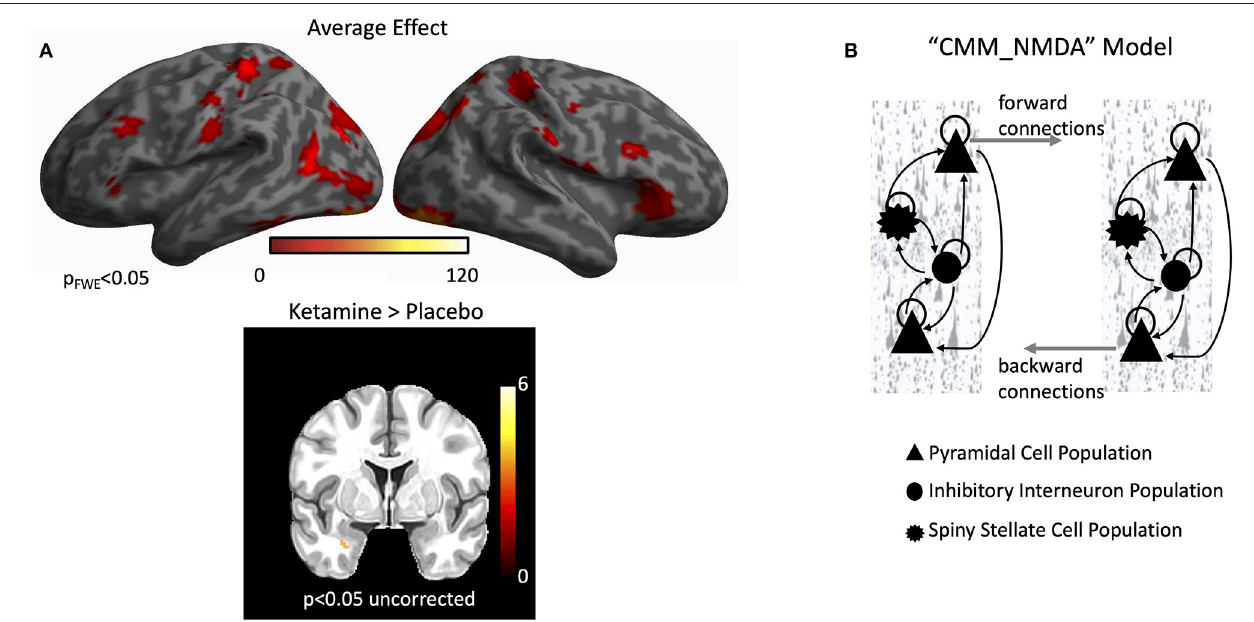
FIGURE 1 | Gamma power and dynamic causal modeling (DCM). (A) A network of regions showed robust increases in induced gamma power during the task. These included the bilateral early visual cortex, bilateral fusiform cortex, and bilateral inferior frontal gyrus. When directly testing the effect of infusion, higher induced gamma power was found in the left amygdala for the ketamine infusion. (B) The default CMM_NMDA model includes four distinct intrinsic (within region) cell layers: superficial pyramidal cells, spiny stellate cells, inhibitory interneurons, and deep pyramidal cells [adapted from Gilbert et al. (57)]. Intrinsic excitatory connections were mediated by α -amino-3-hydroxy-5-methyl-4-isoxazolepropionic acid (AMPA) and N-methyl-D-aspartate (NMDA) receptors while intrinsic inhibitory connections were mediated by gamma aminobutyric acid (GABA) receptors. Each cell population included a self-gain parameter that reflected precision for each cell type. Each receptor also included distinct time constants and dynamics in the model. Between regions, superficial pyramidal cells carry forward extrinsic signals to excitatory spiny stellate cells. Deep pyramidal cells carry backward extrinsic signals to both superficial pyramidal cells and inhibitory